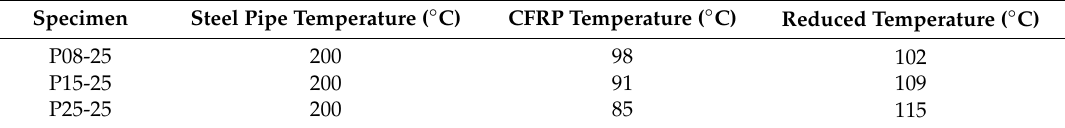
Table 9. The measured temperatures and notation of di ff erent perlite ratios specimens.